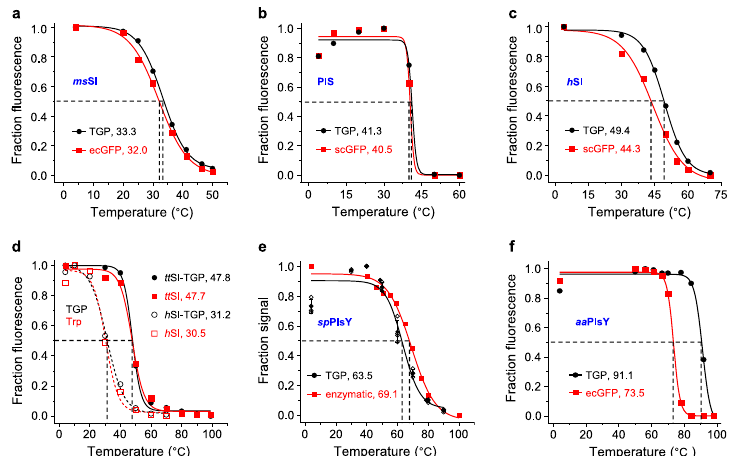
Fig. 2 TGP was a reliable and robust reporter for FSEC-TS assay. T m values of indicated constructs measured by different methods are shown in each panel a – f . Black circles denote data using TGP fl uorescence, and red squares denote data using ecGFP ( a , f ), scGFP ( b , c ), tryptophan fl uorescence ( d ), or enzymatic activity ( e ). In d , solid lines and close symbols denote tt SI samples, and dashed lines and open symbols denote h SI samples. Assays were performed using nonpuri fi ed samples except for d in which the samples had been puri fi ed using His-tag. Data are from a single experiment except for the FSEC data in e which are from four independent experiments. Standard deviation is not applicable for the data points (48.8 and 78.8 °C) because no replicates were performed for these two temperatures. To keep consistent with literature 65 , the heating time was 30 min for aa PlsY. The T m difference of h SI-TGP between c and d is likely due to delipidation effect (see Discussion). FSEC-TS fl uorescence-detection size exclusion